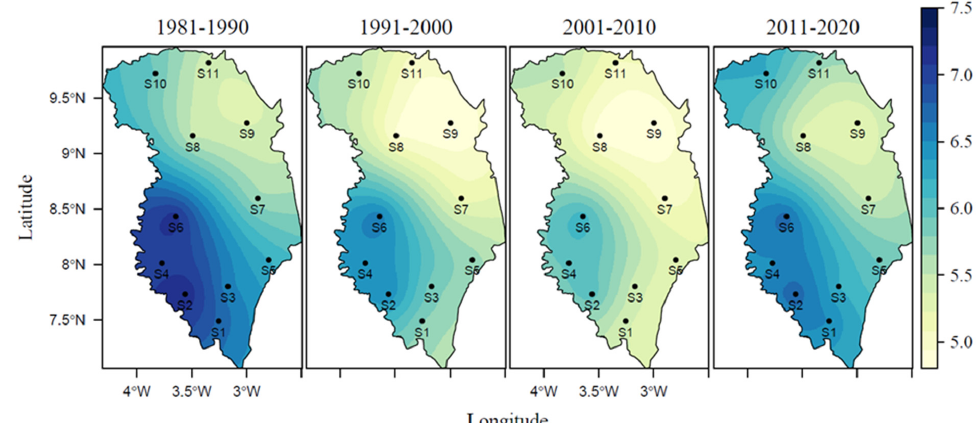
Figure 3. Spatial distribution of the daily precipitation intensity (SDII) (mm/d) per decade in the Zanzan region. Stations (S1 = Koun Fao, S2 = Kouassi-datékro, S3 = Tanda, S4 = Sandegué, S5 = Bondoukou, S6 = Nassian, S7 = Sapli, S8 = PN Comoé S1, S9 = Bouna, S10 = Téhini, S11 = Doropo).